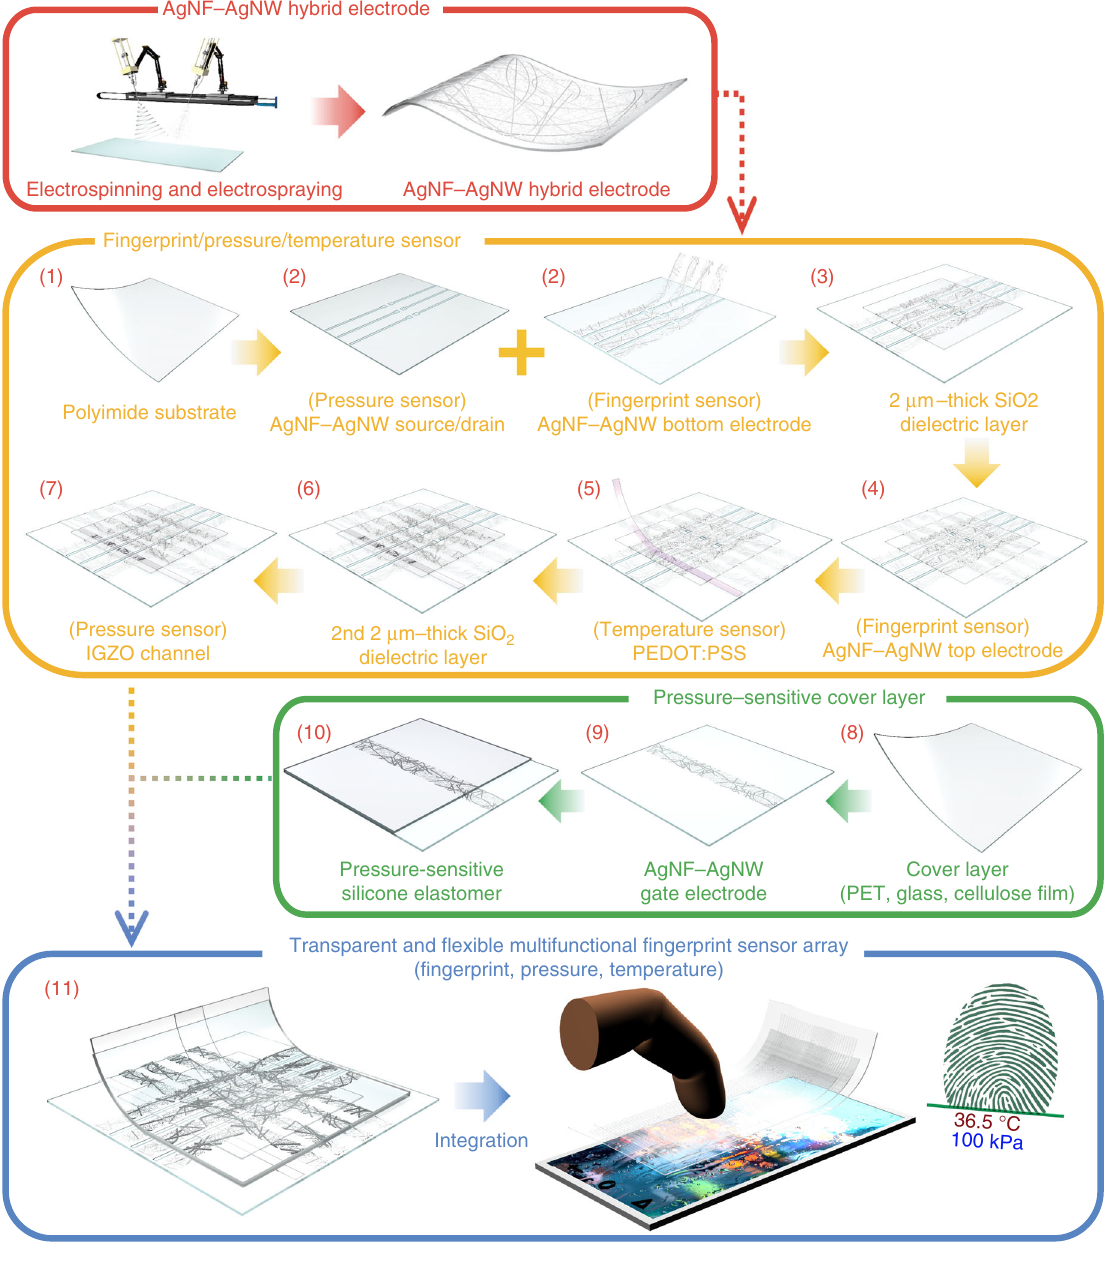
Fig. 1 The fabrication process for the multiplexed fi ngerprint